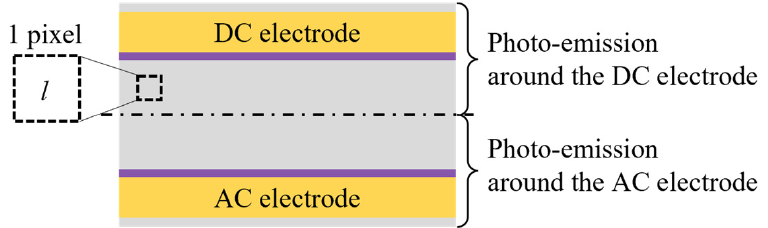
Figure 5. Area for calculating the photoemission strength from the discharge photograph.